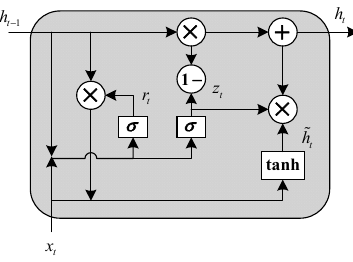
Figure 1. Structure diagram of GRU.